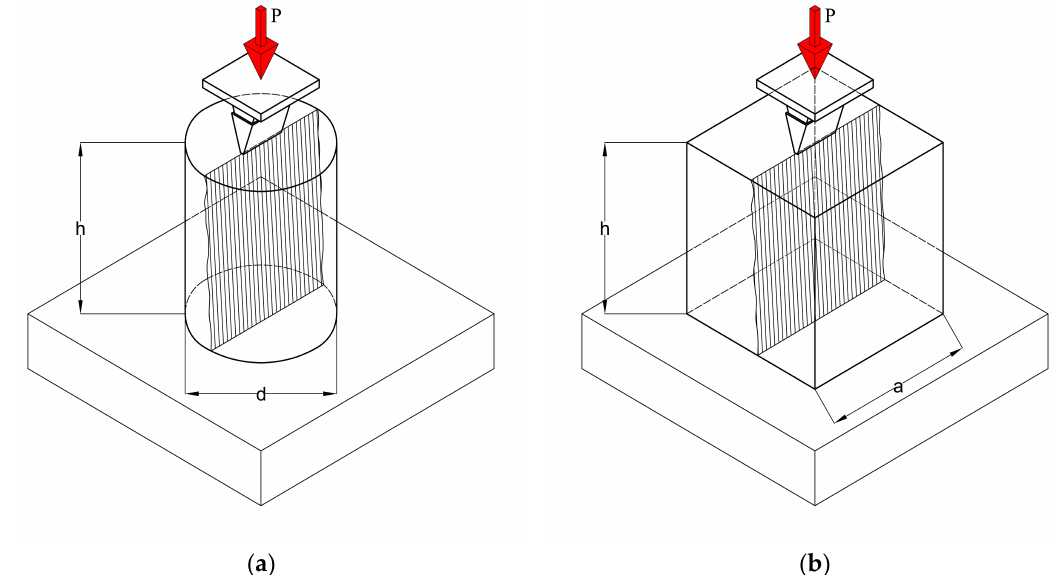
Figure 8. Wedge testing method (Orenstein and Koppel): ( a ) cylindrical (core) sample and ( b ) cubical sample.